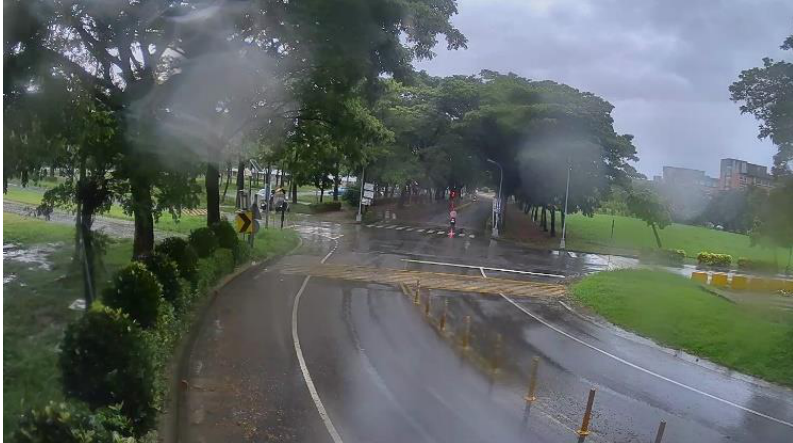
Figure 20. Rainy scene: original image.